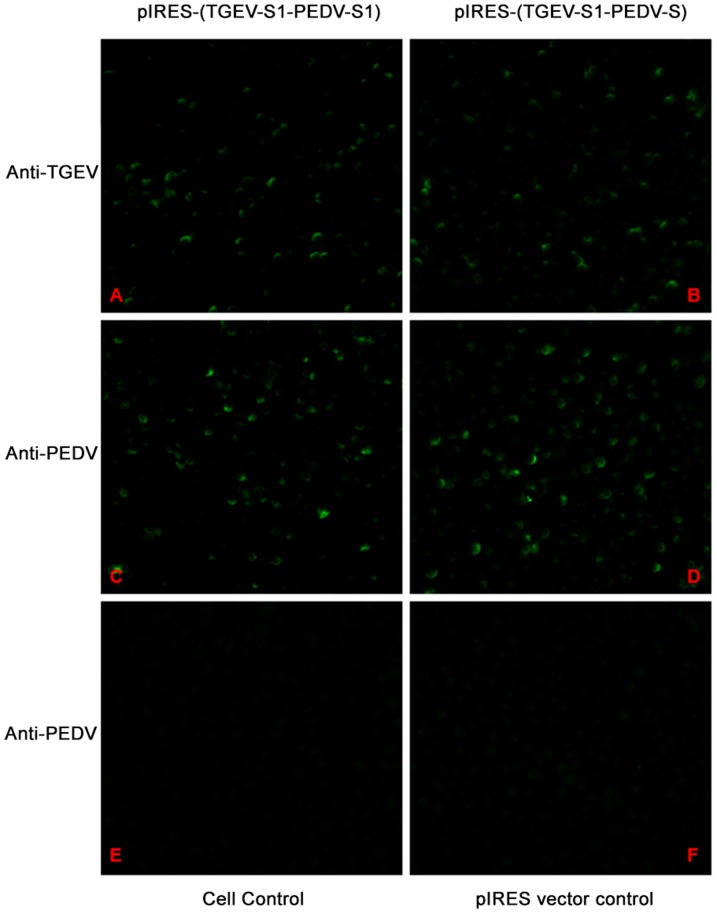
Immunofluorescence analysis of cells transfected with recombinant plasmids.BHK-21 cells were transfected with pIRES-(TGEV-S1-PEDV-S1) or pIRES-(TGEV-S1-PEDV-S). Transient expression of proteins within the transfected cells was detected with anti-PEDV antibodies and anti-TGEV antibody respectively. The green signals reflect expression of the respective proteins of interest. (A) and (B): Cells transfected with pIRES-(TGEV-S1-PEDV-S1) and pIRES-(TGEV-S1-PEDV-S); transiently expressed TGEV S1 protein was detected by anti-TGEV antibody; (C) and (D): transient expression of PEDV S protein was detected by anti-PEDV antibody; (E): cell control; (F): pIRES vector control. Samples in E and F were stained by anti-PEDV. The same pictures were obtained when control cells were stained by anti -TGEV (not shown).